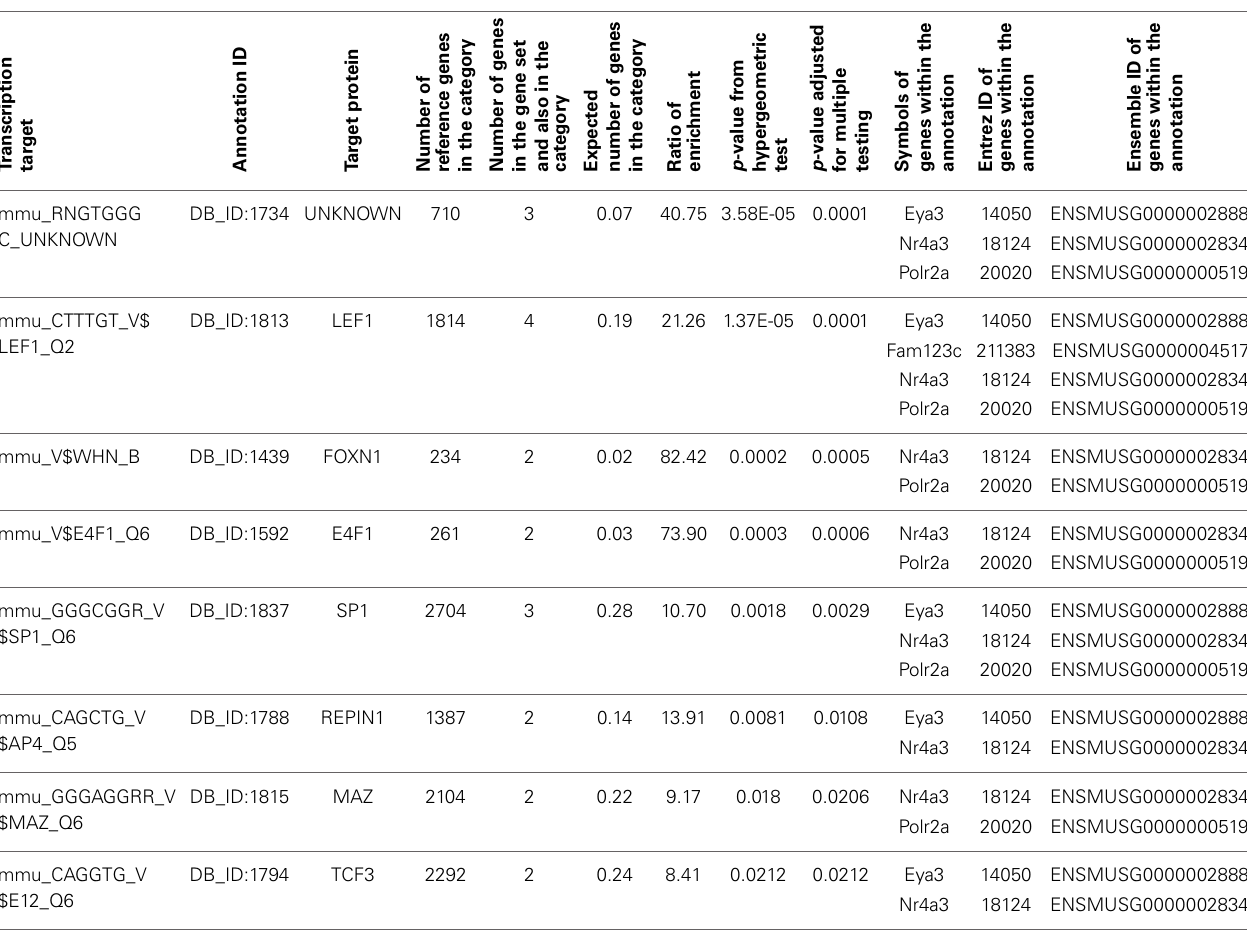
Table 1 | Transcription factor target annotation enrichment from WebGestalt for our six candidate genes, Amer3 ( Fam123c ), Eya3 , Mtdh , Nr4a3 , Polr2a, and Tbkbp1